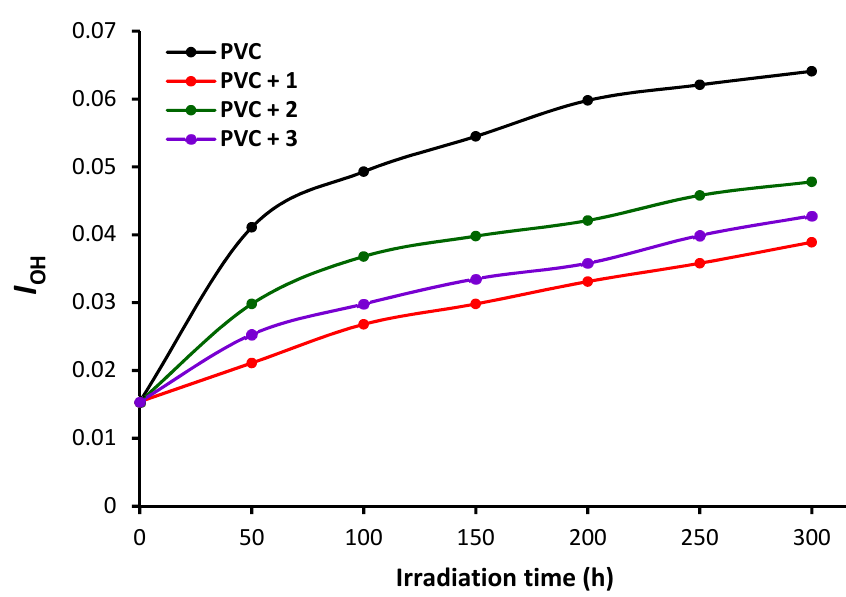
Figure 8. Changes in the I OH upon irradiation.